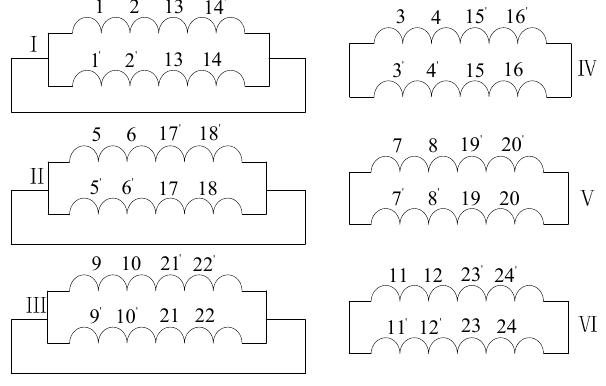
Figure 5. The connection of rotor windings.